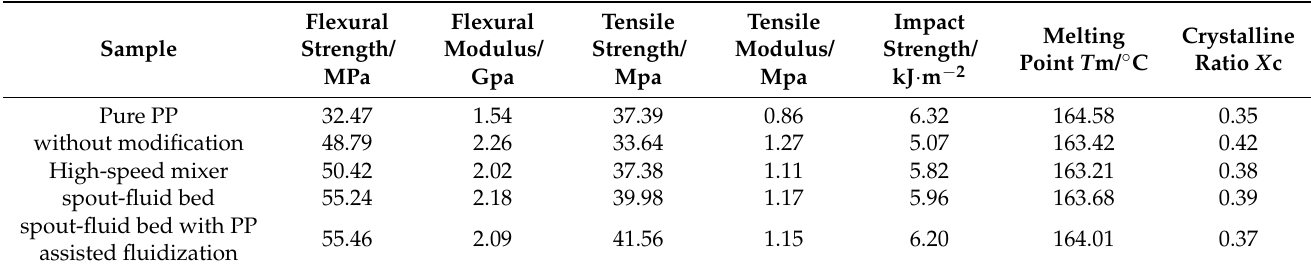
Table 1. Mechanical properties of PP/N-WPCB composites prepared with different methods.